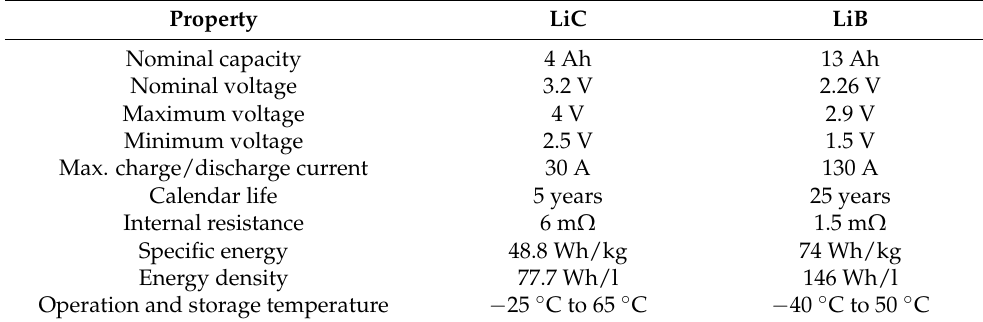
Table 1. Datasheet parameters of LiB and LiC.